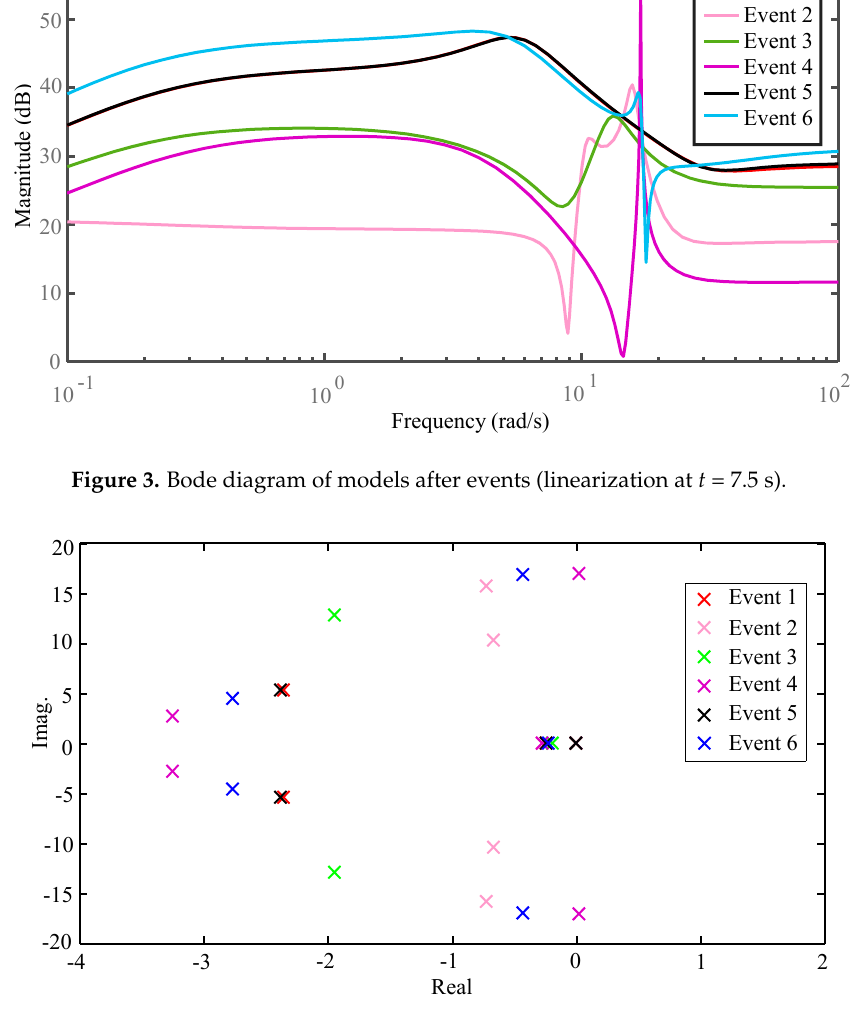
Figure 4. Modes of reduced order models (linearization at t = 7.5 s).